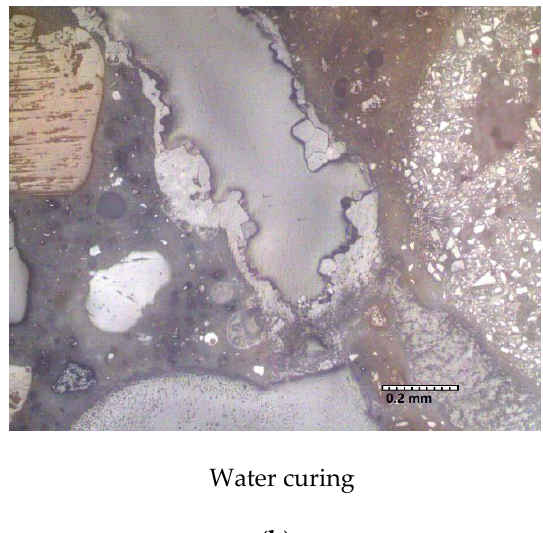
Figure 9. Healing products in deep cracks under different exposure environments: ( a ) control; ( b ) with bacteria.